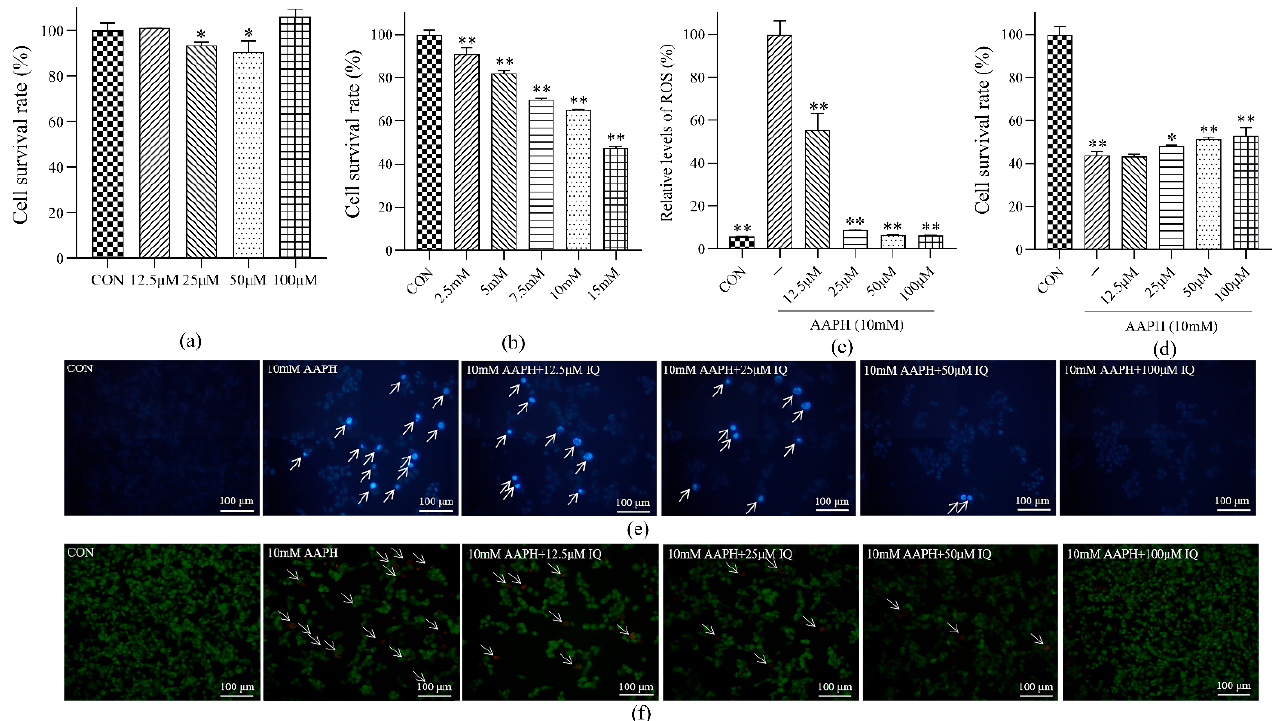
Figure 1. Effect of IQ on AAPH-induced viability and apoptosis of MC3T3 cells. ( a ) Cytotoxicity experiment of IQ on MC3T3 cells; ( b ) concentration screening experiment of AAPH on MC3T3 cells oxidative damage; ( c ) detection experiment of IQ on the relative level of ROS in MC3T3 cells induced by AAPH; ( d ) protective experiment of IQ on AAPH-induced MC3T3 cells oxidative damage and apoptosis; ( e ) staining of apoptotic bodies in the MC3T3 cell nucleus (Hoechst 33342); ( f ) staining experiment of MC3T3 during nuclear apoptosis (AO/EB). Experiments were performed in triplicate, and the data were expressed as the mean ± SD, * p < 0.05, ** p < 0.01.